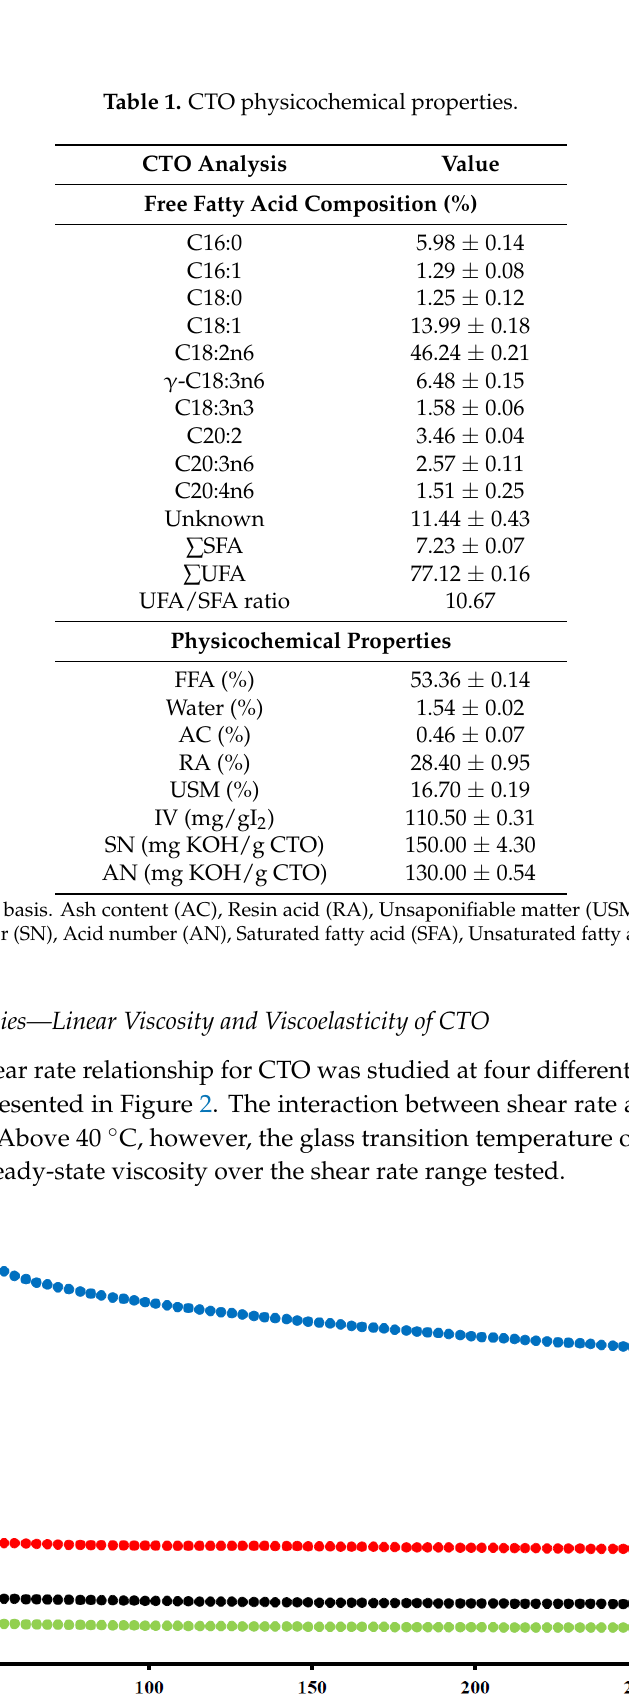
Figure 3. Impact of temperature on the viscosity distribution profile of CTO. The flow curves were studied at different temperatures to illustrate the onset of non ‐ Newtonian behavior. The temperature was ramped from 30 to 60 °C at 5 °C/min by loading the sample onto the rheometer plate to fill up the space between the geometry and the plate. The results were plotted in terms of shear stress vs shear rate (Figure 4). During the model analysis, five flow model types